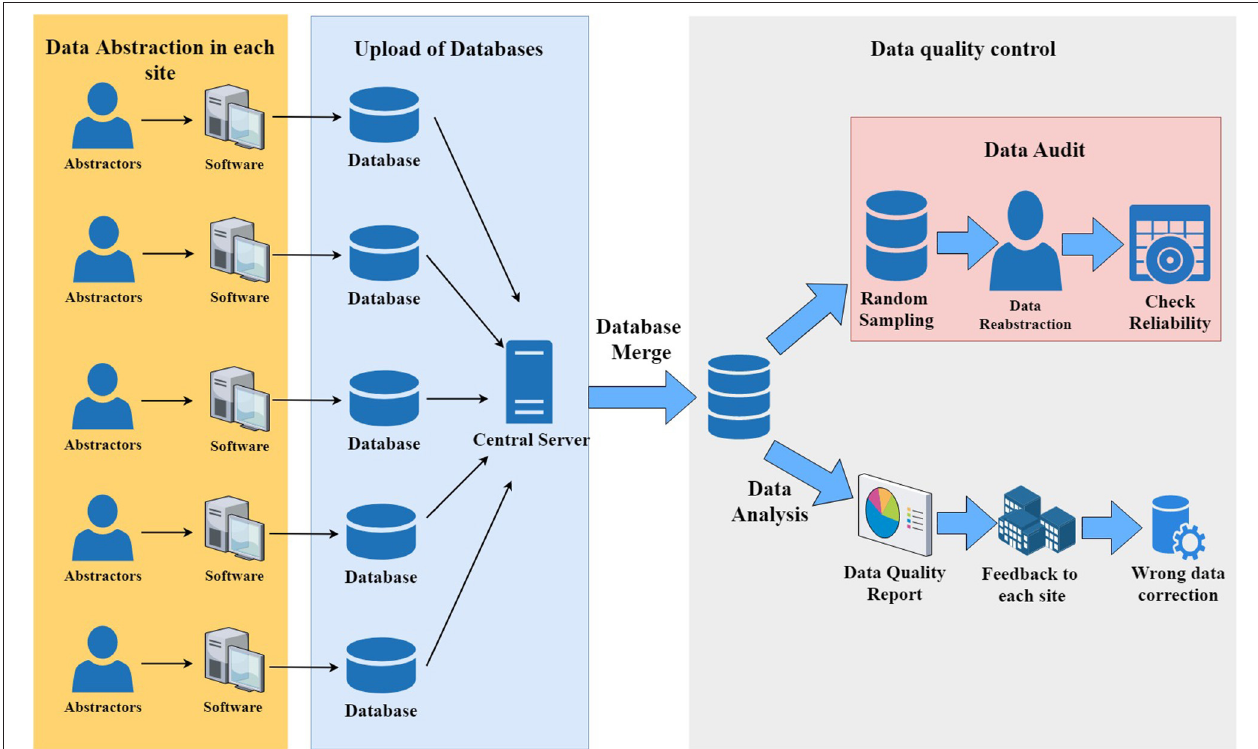
FIGURE 1 | Data collection and data quality control in the Chinese Neonatal Network data collection